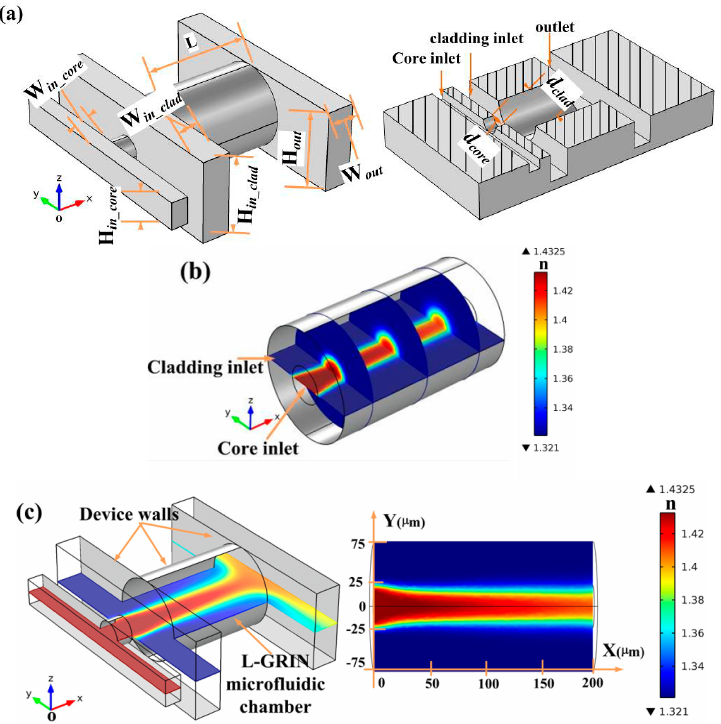
Figure 1. ( a ) Structure diagram of the tunable L-GRIN microlens (left graph), in which H in_core = 50 µ m, W in_core = 30 µ m, H in _ clad = 150 µ m, W in_clad = 50 µ m, H out = 150 µ m, W out = 50 µ m. The xoy cross-sectional view of the L-GRIN microlens together with the substrate (right graph), in which d core = 50 µ m, d clad = 150 µ m; ( b )The simplified model of the microfluidic chamber; ( c ) Simulated refractive index profile in the microfluidic chamber (left graph) and the refractive index profile in the xoy plane (right graph).